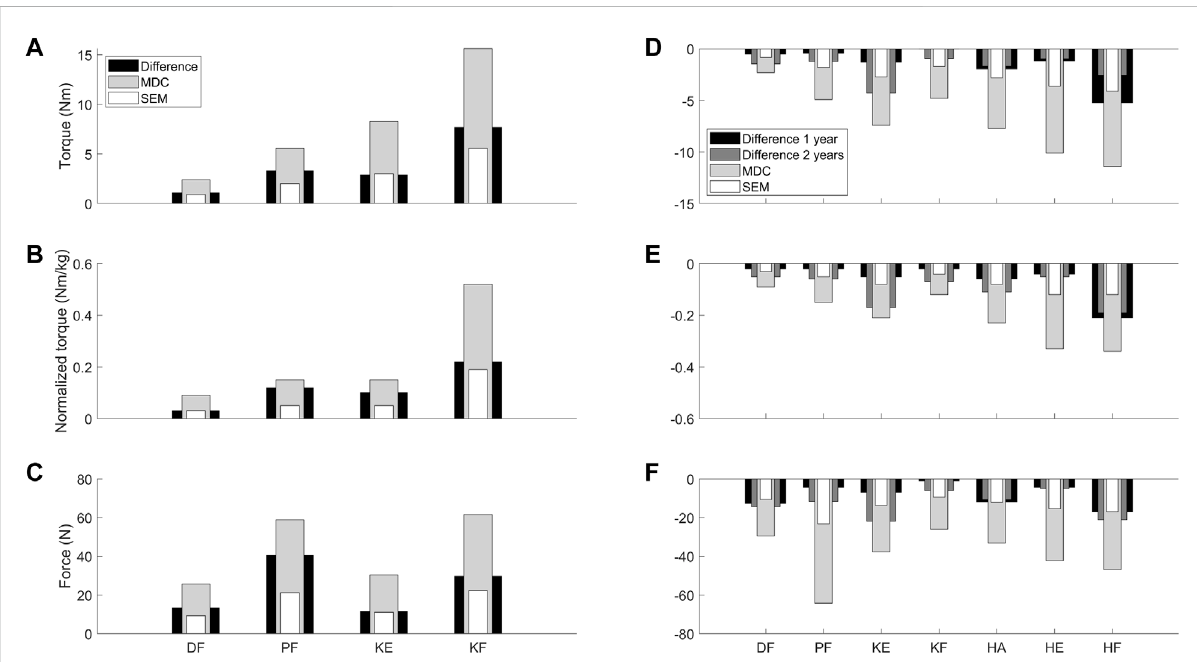
FIGURE 4 VisualrepresentationtocomparetheabsoluteSEM(white)andMDC(lightgrey)valuesasretrievedfromthereliabilitystudyforthechildrenwith CP and DMD with the median of the absolute differences between the two assessments (black = CP and 1 year interval DMD; dark grey = 2 year interval DMD) from the responsiveness study. Panel A-C visualize the data for torque (A) , normalized torque (B) and the force (C) in the children with CP. Panel D-F visualize the data for torque (D) , normalized torque (E) and the force (F) in the children with DMD. Abbreviations in alphabetical order: CP, cerebral palsy; DF, dorsi fl exion; DMD, Duchenne muscular dystrophy; HA, hip abduction; HE, hip extension; HF, hip fl exion; KE, knee extension;KF,knee fl exion;MDC,minimaldetectablechange;N,Newton;Nm,Newtonmeter;Nm/kg,Newtonmeterperkilogrambodyweight;PF, plantar fl exion; SEM, standard error of